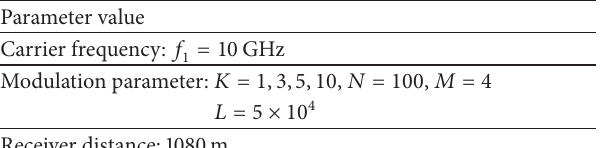
Table 1: Simulation